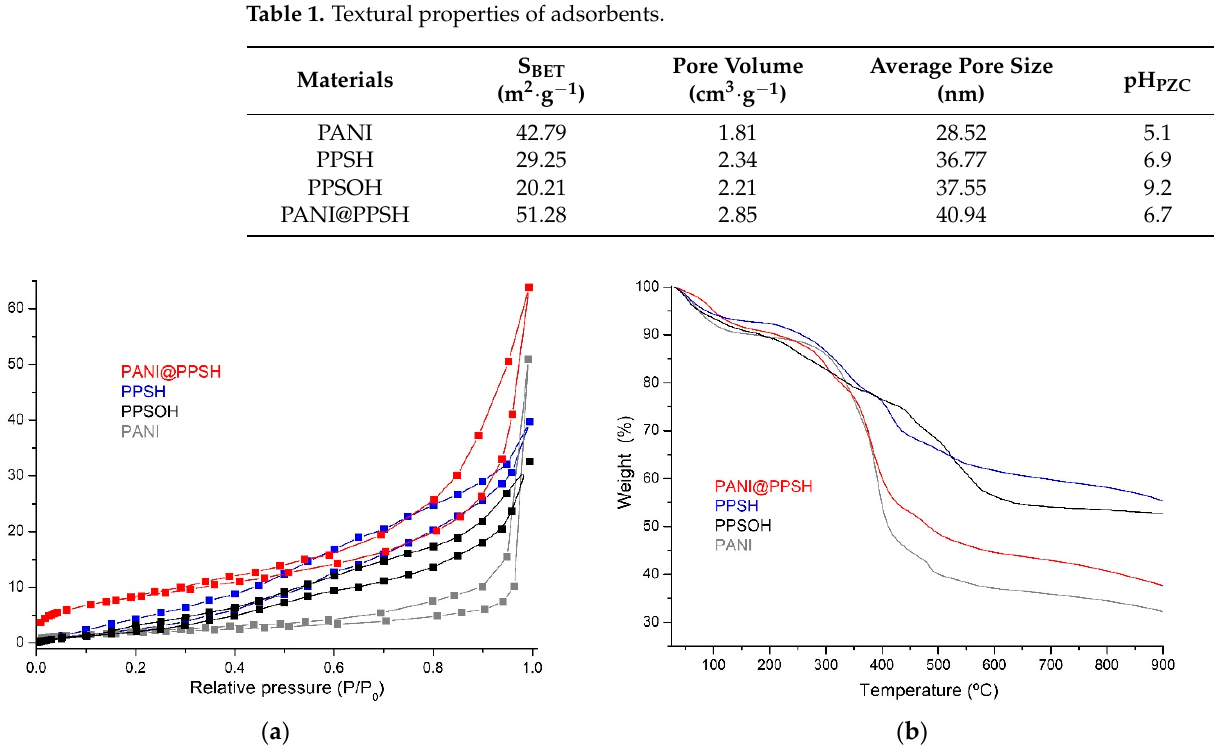
Figure 2. ( a ) Brunauer–Emmett–Teller (BET) surface area and ( b ) thermogravimetric analysis (TGA) of samples.